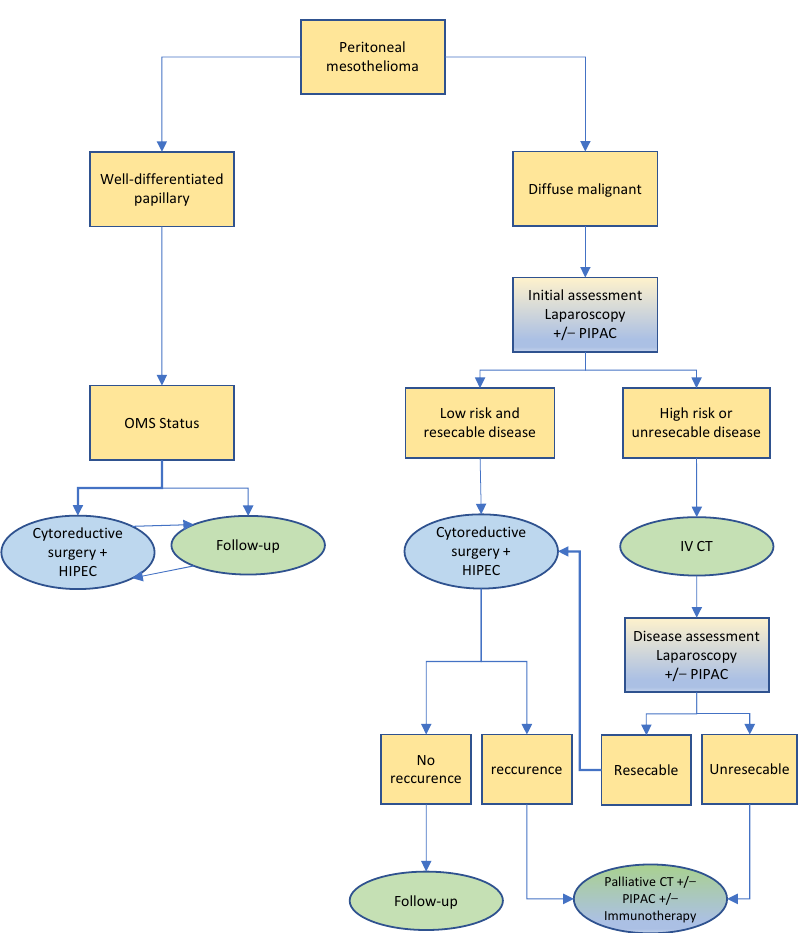
Figure 2. Treatment algorithm for peritoneal mesothelioma